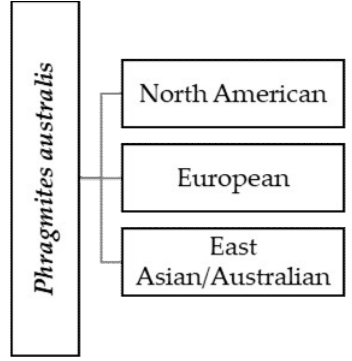
Figure 1. Main phylogeographic groups, sourced from Reference [31].